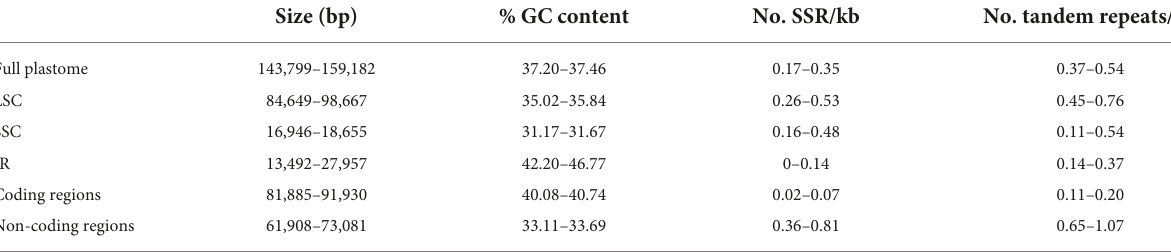
TABLE 1 Minimum and maximum values for the studied Tillandsioideae plastome attributes. Size (bp)